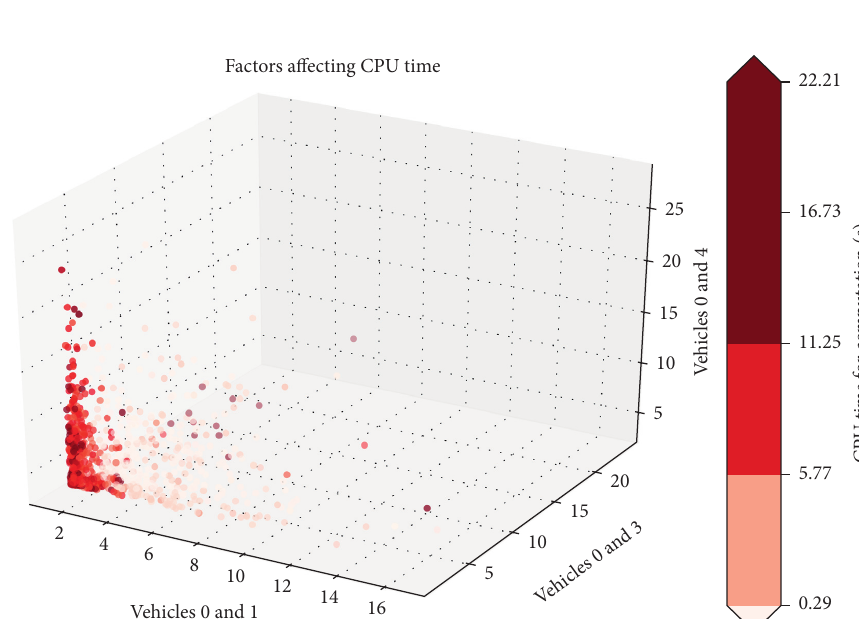
Figure 7: CPU time for solving the SQP